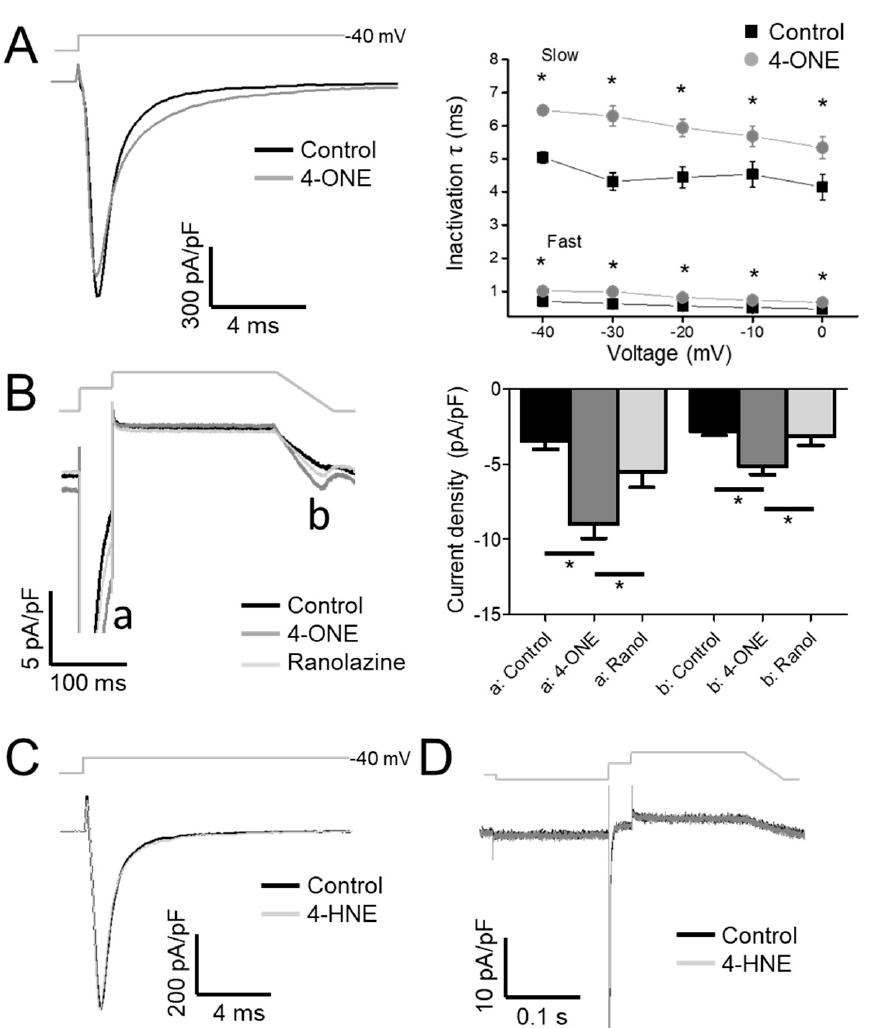
Figure 2. The inactivation decay of I NaV and the late Na + current (I NaL ) by 4-ONE were analyzed. ( A ) I NaV was activated by applying depolarization pulses ( − 40, − 30, − 20, − 10, and 0 mV) from − 120 mV of holding potential. The current decay was analyzed using double exponential fitting. ( B ) I NaL through hNa V 1.5 channel was recorded by applying action potential-like repolarization pulse protocol. The I NaV was activated by short depolarization to − 20 mV from − 120 mV of hyperpolarized potential (a). The resurgent I NaL was then recorded during ramp pulse repolarization (b). ( C , D ) 4-HNE treatment induced neither the inactivation decay of I NaV nor the I NaL . All the data were analyzed using paired t -tests, where a p < 0.05 was considered statistically significant ( ∗ ).